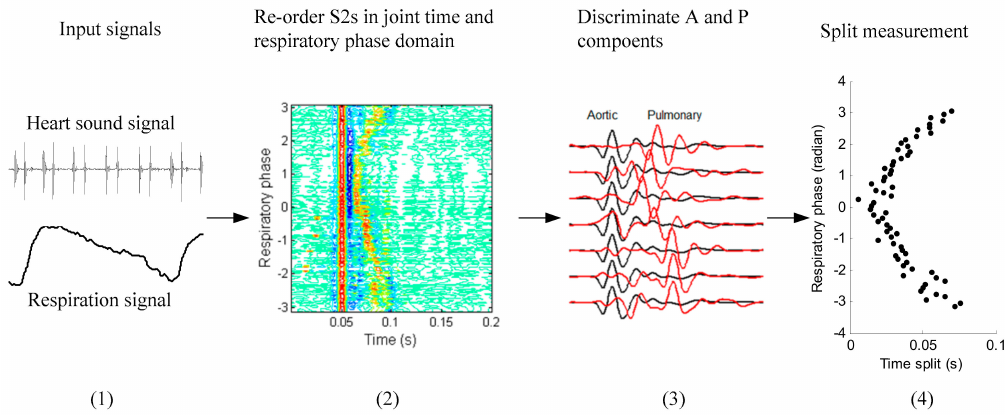
Figure 4. Overview of the